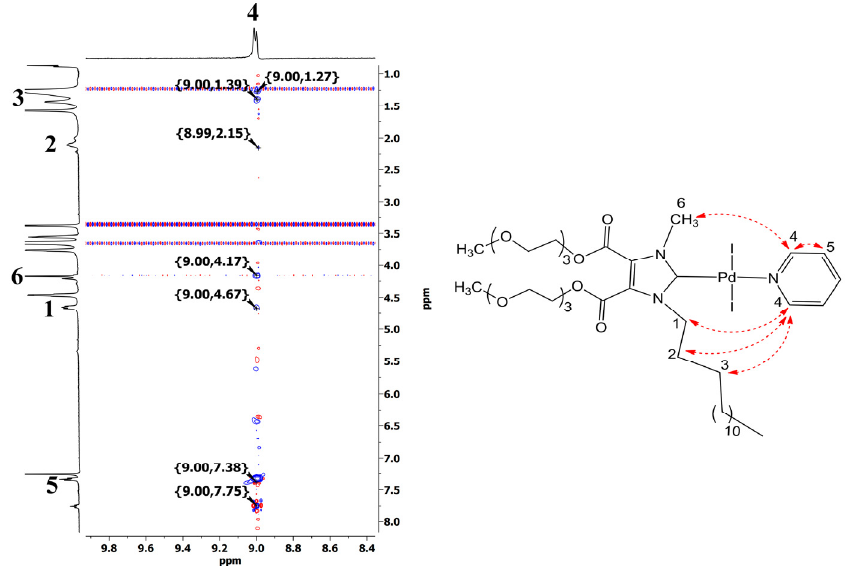
Figure 1. Fragment of 2D NOESY 1 H- 1 H spectrum of 4b (CDCl 3 , 25 °C).